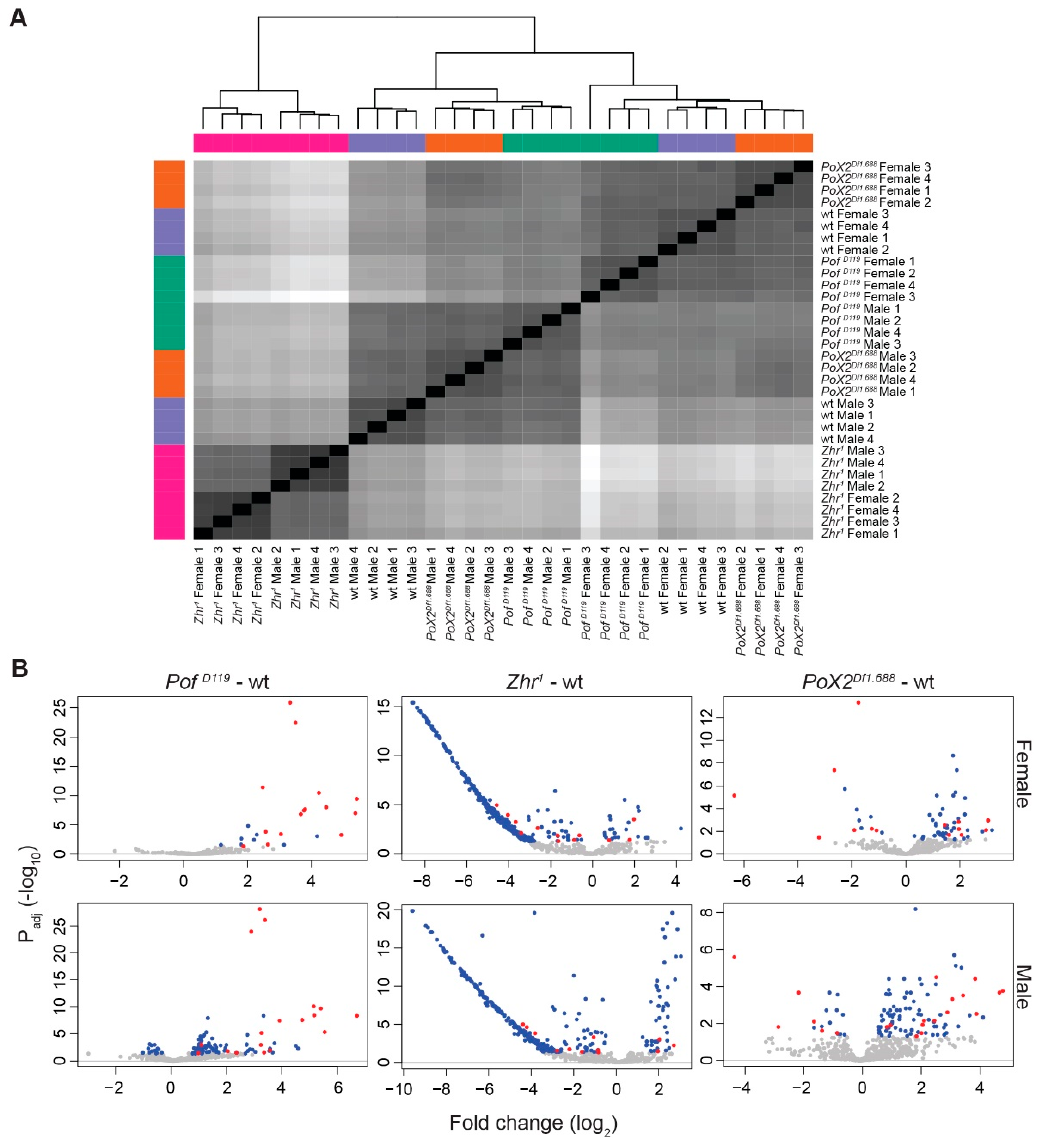
Figure 5. Satellites analysis in the mutants versus wild type. ( A ) Heatmap of Euclidian distances of RLT 1.688 satellite block read counts clusters the samples of Zhr 1 separated from Pof D119 and PoX2 Df1.688 . ( B ) Satellite blocks on the X-chromosome are denoted in red, and satellite block on non-X-chromosomes are blue. Grey dots are non-significant hits ( P adj > 0.05). The largest di ff erence of satellite block expression on autosomal and unclassified chromosomes is found in Zhr 1